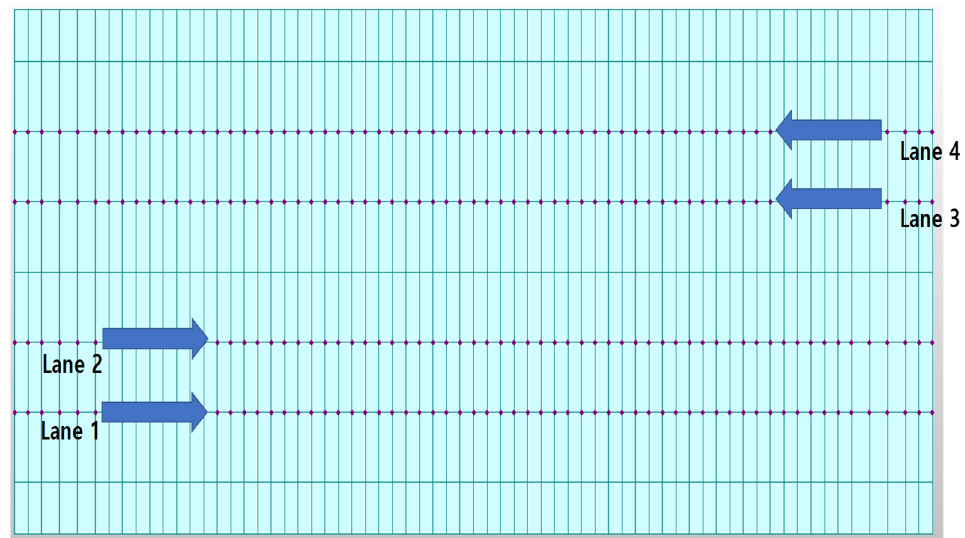
Figure 3. Traffic load points for rigid-frame-bridge modeling (Four lanes indicate the locations for the moving point load used to simulate the rigid-frame bridge.).